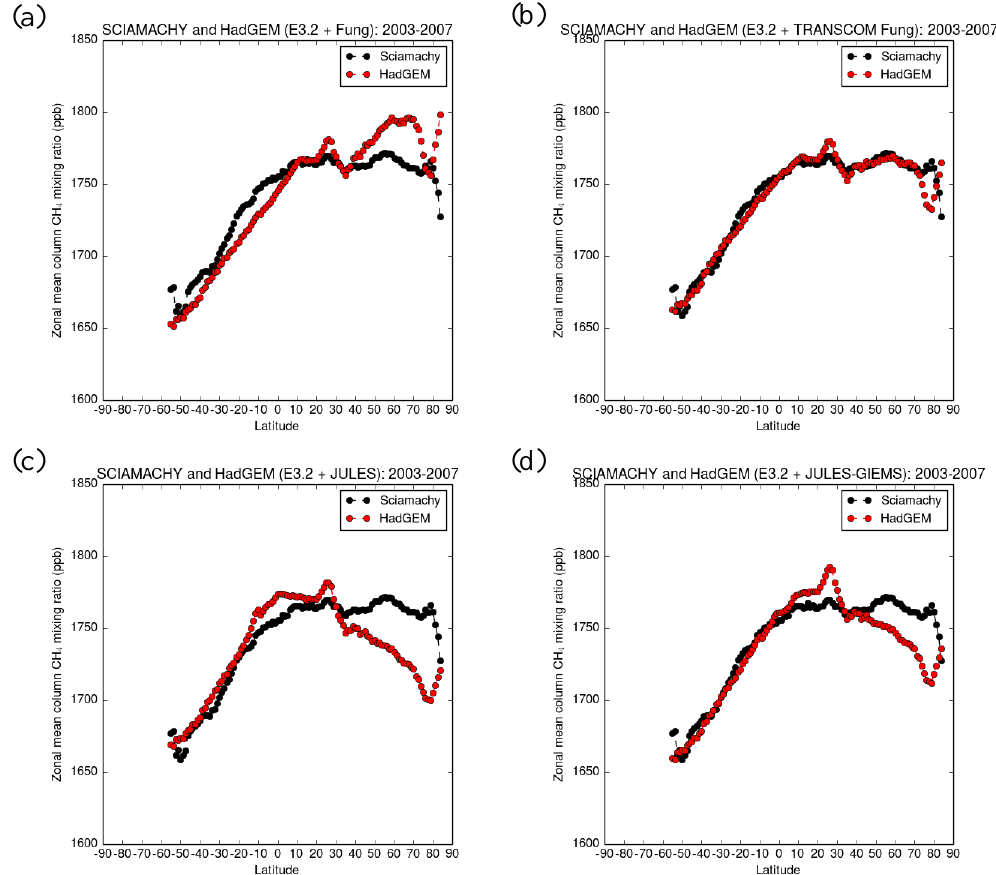
Figure 9. Comparisons of the latitudinal distribution of the average atmospheric column methane mixing ratio between the years 2003 and 2007, as derived from monthly regridded SCIAMACHY data and from the HadGEM2 runs using the FUNG (a) , TRANSCOM-FUNG (b) , JULES (c) and JULES-GIEMS (d) wetland emission inventories and the EDGAR v3.2 (E3.2) anthropogenic methane emission time series, sampled at co-located space and time points. Note that the SCIAMACHY data between 60 and 90 ◦ S have been removed because of their sparsity and